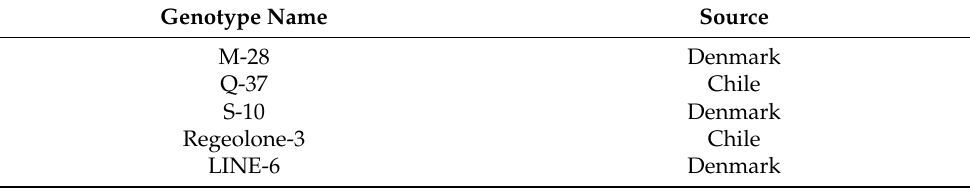
Table 1. Name and origin of the studied